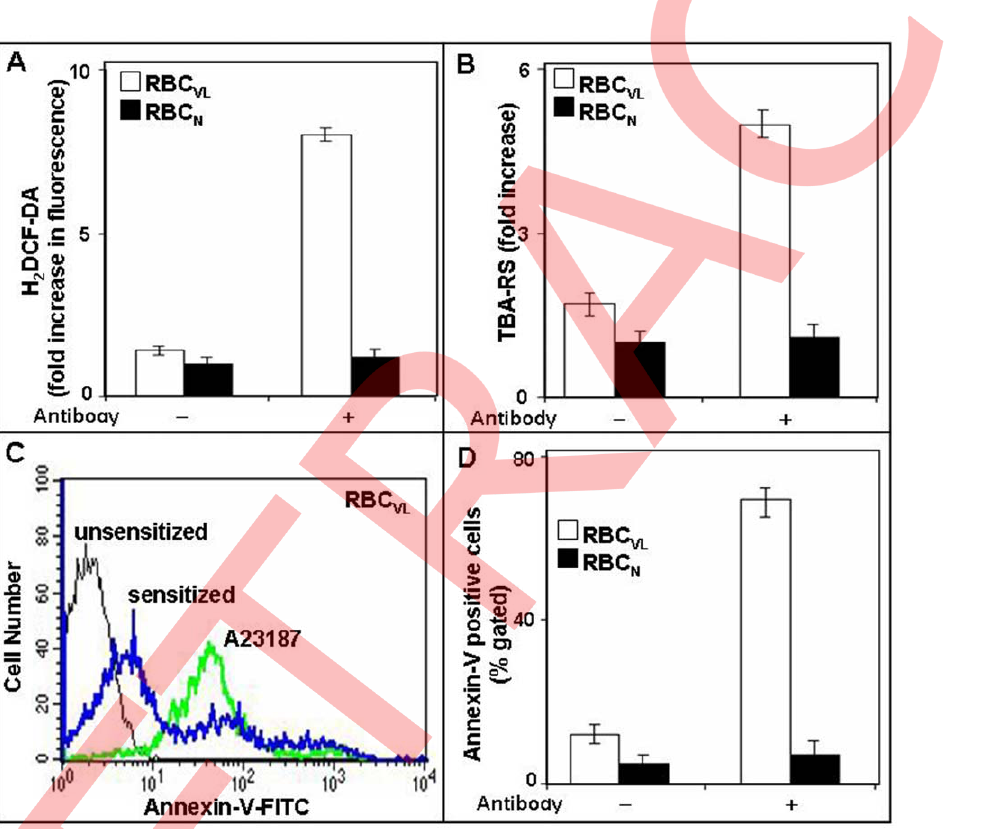
Figure 1. Altered membrane properties and reduced stability of RBC VL after sensitization with anti-9- O -AcSGP IgG VL antibodies. A. The osmotic fragility of RBC VL (open square) compared to RBC N (filled square) was measured by degree of hemolysis with increasing osmotic stress by incubation in NaCl (0–0.9%) determined by spectrophotometry. Data are represented as % hemolysis, are means of triplicates 6 SD and representative of three independent experiments. B. Sensitization of RBC VL for hemolysis with anti-9-O-AcSGP IgG VL antibodies. RBC VL (open bars) and RBC N (filled bars) were incubated for 30 min at 37 u C with increasing concentration (0.5 m g/ml–12.0 m g/ml) of anti-9- O -AcSGP IgG VL and anti-9- O - AcSGP IgG NHS , respectively. The extent of hemolysis was then determined by spectrophotometry. The Spectrophotometric readings of RBC VL or RBC N in buffer under similar condition were taken as base values and subtracted from the experimental values. Data are expressed as means 6 SD of three independent experiments. C. Kinetics of the hemolysis of RBC VL and RBC N after sensitization with anti-9-O-AcSGP IgG VL antibodies. RBC VL (open squares) and RBC N (filled squares) were incubated with equal (6.0 m g/ml) amounts of anti-9- O -AcSGP IgG VL and anti-9- O -AcSGP IgG NHS , respectively, for different time points (0–120 min). Base value was routinely subtracted from each experimental value as in Fig. 1B. Data are means 6 SD of three independent experiments. D. Hemolysis of RBC N (filled bars) and RBC VL (open bars) after sensitization of RBC VL with anti-9- O -AcSGP IgG NHS or anti-9- O -AcSGP IgG VL (6.0 m g/ml), respectively, or incubation with the calcium ionophore A23187 (1 m M) in Ringer solution for 30 min. Data are means 6 SD of three independent experiments. E. Enhanced membrane hydrophobicity of RBC VL after sensitization with anti-9-O-AcSGP IgG VL . The hydrophobicity was determined spectrofluorimetrically using ANS as indicator. RBC VL were incubated with anti-9- O -AcSGP IgG VL antibodies or PBS only for 30 min at 37 u C. As controls, RBC N were incubated with anti-9- O -AcSGP IgG NHS . The cells were washed with PBS, loaded with ANS and incubated for 1 h at 37 u C. The fluorescence emission spectra were recorded from 400 to 850 nm with excitation at 365 nm. The graphs are representatives of the results obtained from three independent experiments. F. Morphological changes of RBC VL after sensitization with anti-9-O- AcSGP IgG VL antibodies. RBC N and RBC VL were not sensitized or sensitized with anti-9- O -ACSGP IgG NHS or anti-9- O -AcSGP IgG VL antibodies, respectively, (6.0 m g/ml) for 30 min at 37 u C, and then processed for SEM as described in Materials and Methods. Representative images from three independent experiments are shown. G. Decrease of RBC VL cell size after sensitization detected by low-angle scattering light flow cytometry (forward scatter, FCS). FCS was measured of RBC N (upper left panel) and of RBC VL without sensitization (upper right panel) or with sensitization with anti-9- O - AcSGP IgG VL (2.5 m g/ml) (lower left panel) or treatment with A23187 (1.0 m M) (lower right panel). Figure 1F is excluded from this article's CC-BY license. See the accompanying retraction notice for more information.